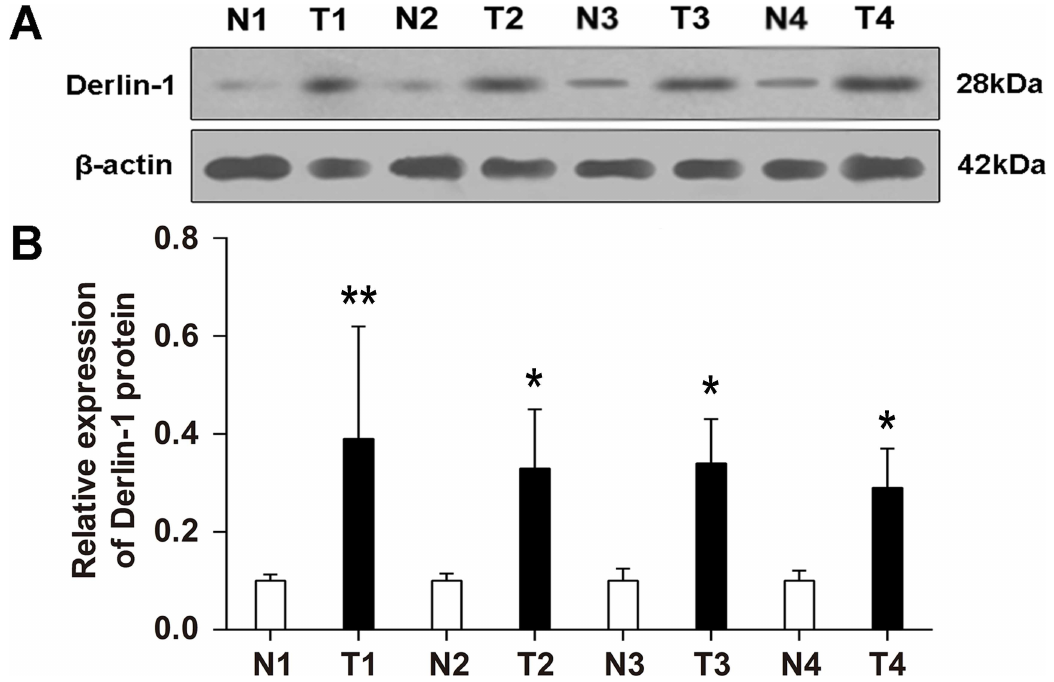
Fig 3. Derlin-1 protein expression in normal mucosa and bladder cancer. (A) Representative graphic of western blot analysisof Derlin-1 protein expressionin bladdercancer tissues (T) and paracancerous tissues (N) from four patients. (B) Statistical result. * P < 0.05, ** P <